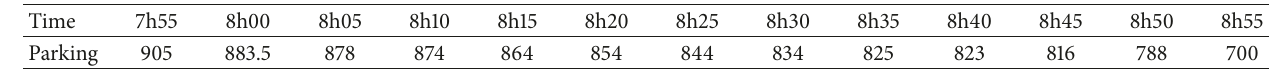
Table 3: Data for 𝑃1 of Balexert parking with average number of available parking